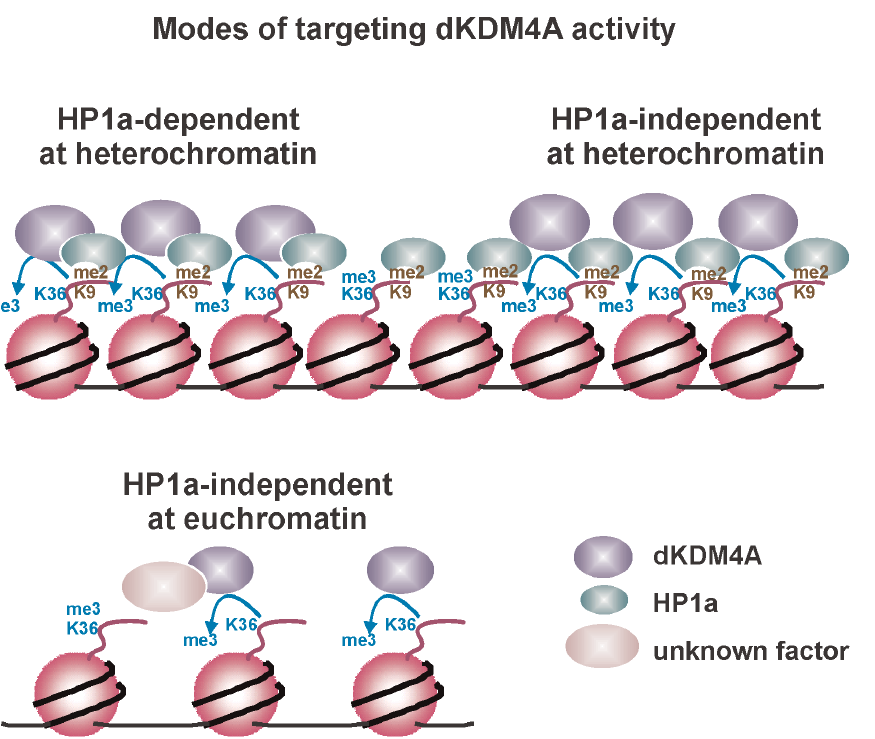
Figure 5. Model for HP1a targeting dKDM4A activity to a subset of heterochromatic genes. Demethylation of H3K36me3 by dKDM4A requires binding to HP1a at a subset of heterochromatic loci. Other mechanisms might exist to target dKDM4A activity to euchromatin, as well as heterochromatin. For example, dKDM4A might be targeted to euchromatin through other protein factors.